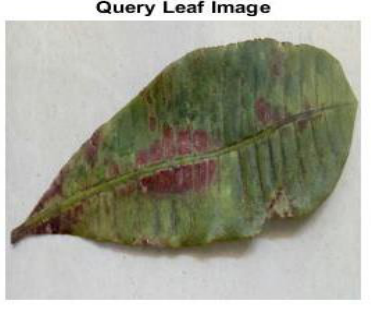
Figure 3: Input image